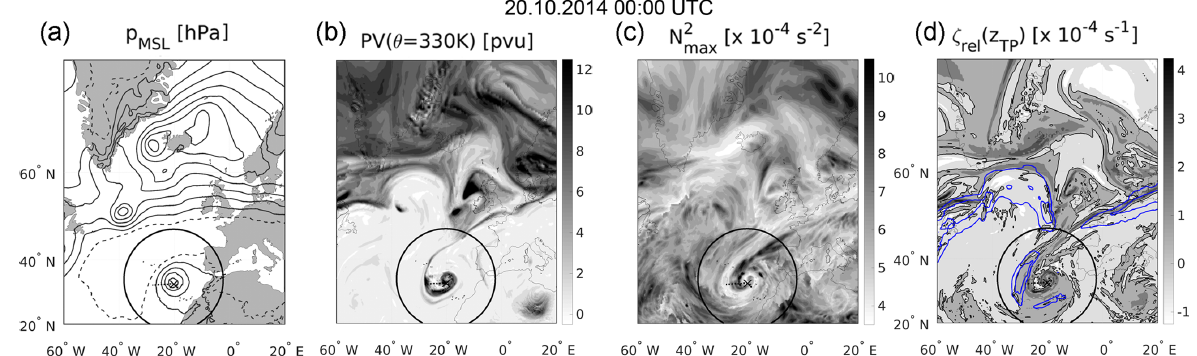
Figure 6. As in Fig. 3, but only for one point in time, showing the tracked cyclone associated with the upper tropospheric cut-off from the previous baroclinic wave